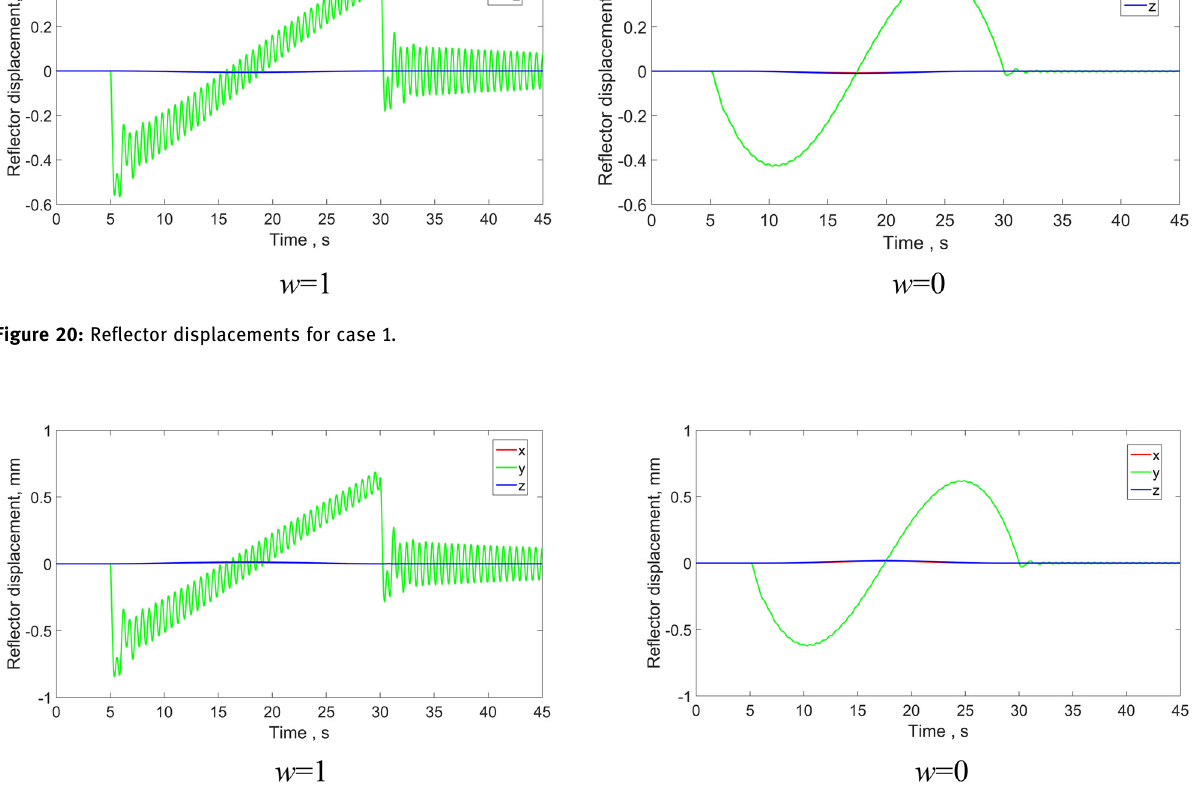
Figure 21: Re fl ector displacements for case